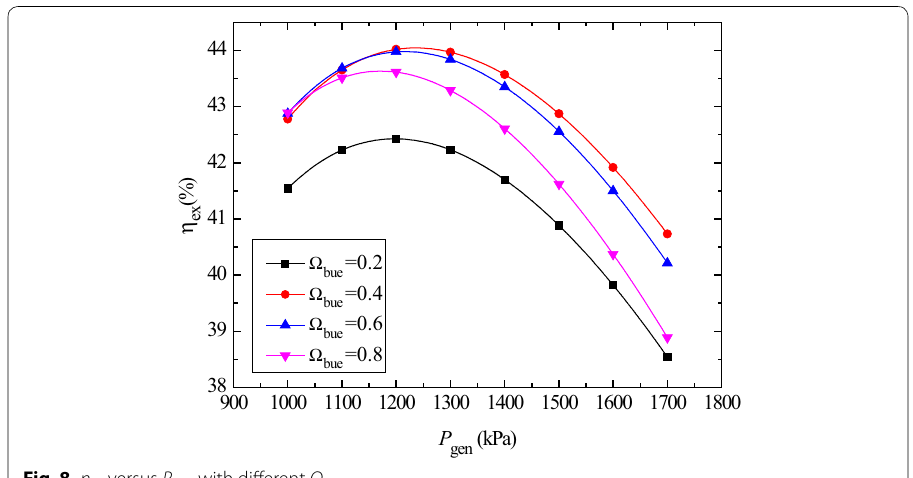
Fig. 8 η ex versus P gen with different Ω